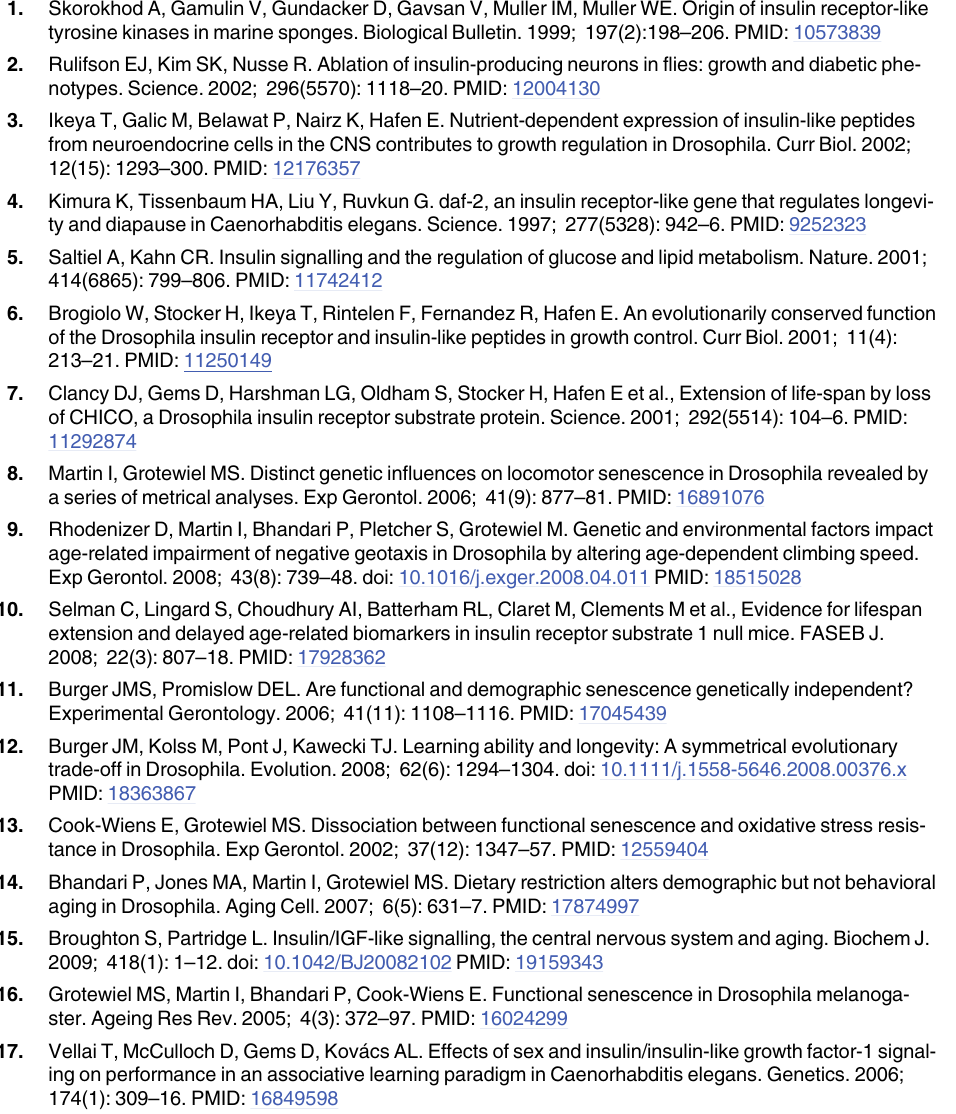
S7 Fig. The performance of female flies of the indicated genotype at weekly time points throughout life in olfactory avoidance behaviour. The olfactory avoidance assay was per- formed and performance index calculated as described in Anholt et al (1996). Benzaldehyde was used at a concentration of 0.03%